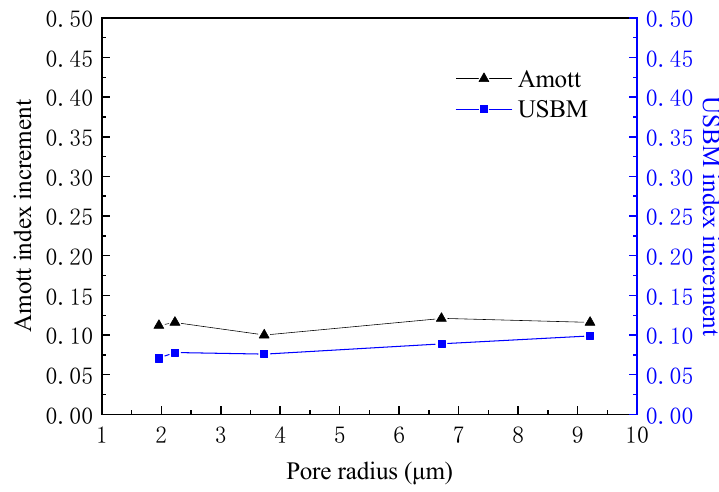
Figure 11. Wettability alteration value vs. pore radius. The average core wettability alteration before and after VES filtration was investigated using initially neutral cores. The results showed that all neutral cores were altered to be more water-wet after VES filtration, and the variation trend in Amott and USBM indexes was similar. Dynamic aging induced a more significant wettability alteration than static aging. As the concentration of VES increased, the viscosity of the VES solution increased rapidly, and this, in turn, increased the adsorption of VES in the core, which promoted the overall wettability of the core to become more hydrophilic. When increasing the filtration flow rate, some high viscosity VES aggregates are destroyed by shear, which results in a decrease in IPV and more retention in the core [28]. As a consequence, more interaction between the VES and pore-wall surface occurs, which alters the wettability of core to become more hydrophilic. In higher permeability cores, the IPV reduction allows the VES to remain in more pores, which slightly alters the overall wettability of the core to become more